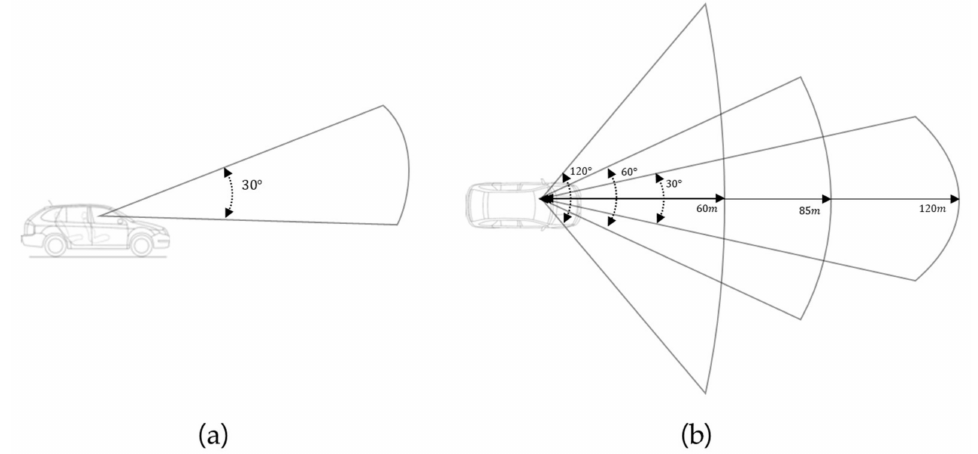
Figure 3. Three types of visual perception depending on speed. ( a ) Vertical visual angle of all types of perception fixed at 30 ◦ . ( b ) Three types of visual perception models according to vehicle